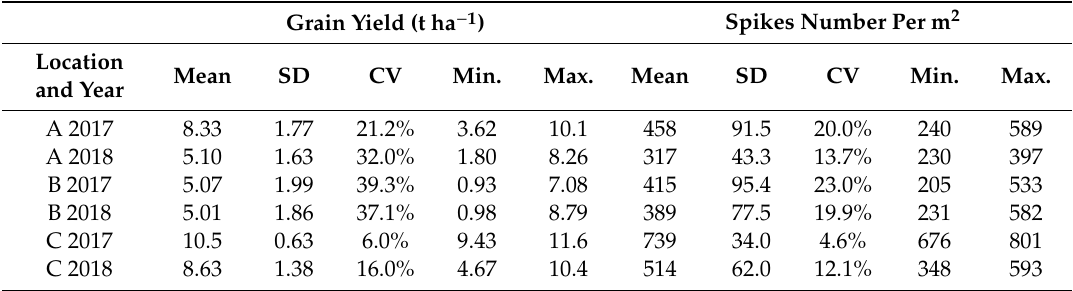
Table 3. Grain yield (t ha − 1 ) and number of spikes per m 2 m in sampling points at harvest in Bro˙z ó